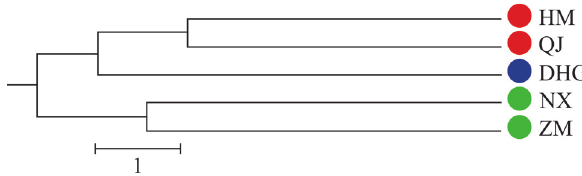
Figure 2 - Dendrogram of cultivated R. tanguticum obtained by UPGMA cluster analysis. The three clusters obtained in this analysis are identified by different colored circles.